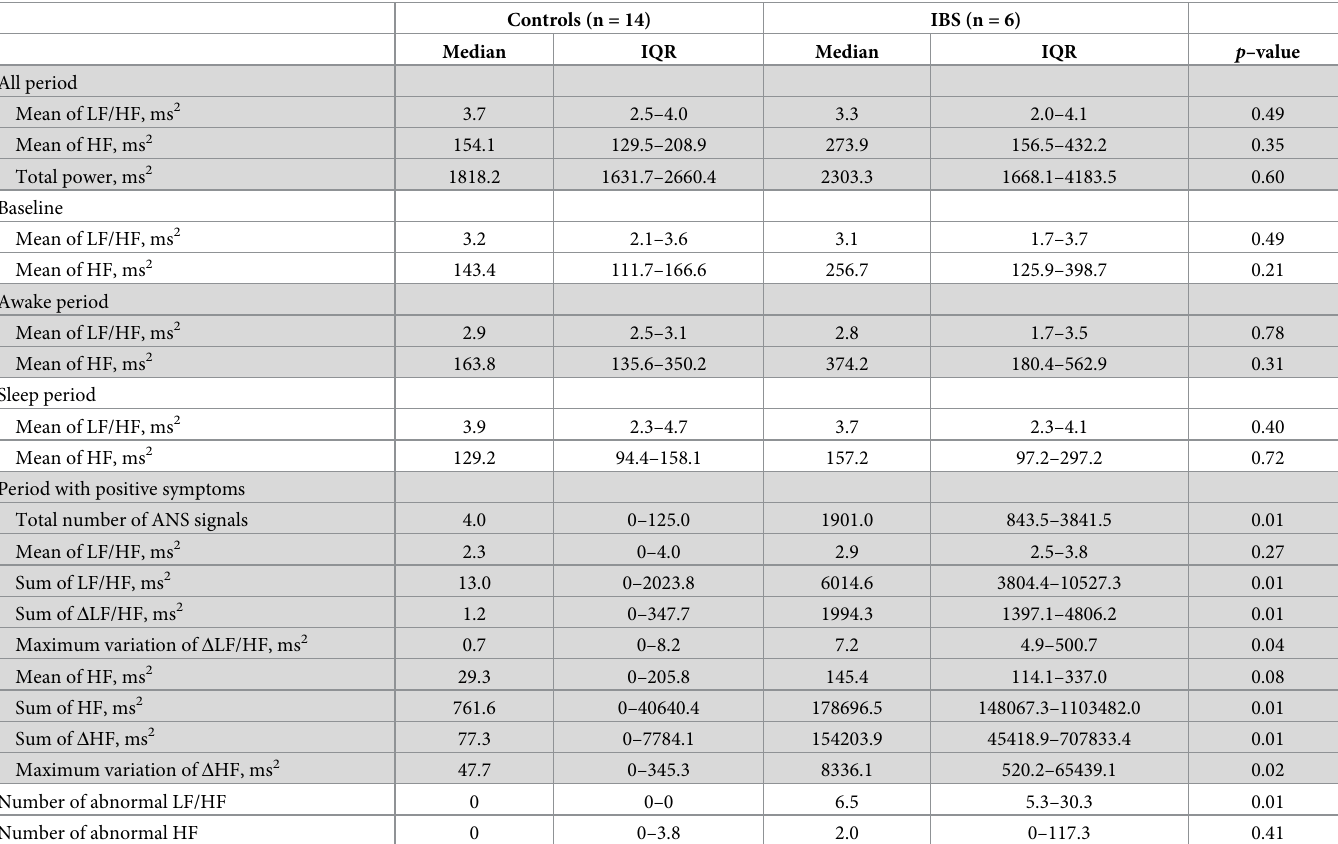
Table 2. Autonomic nervous system activity in healthy controls and patients with